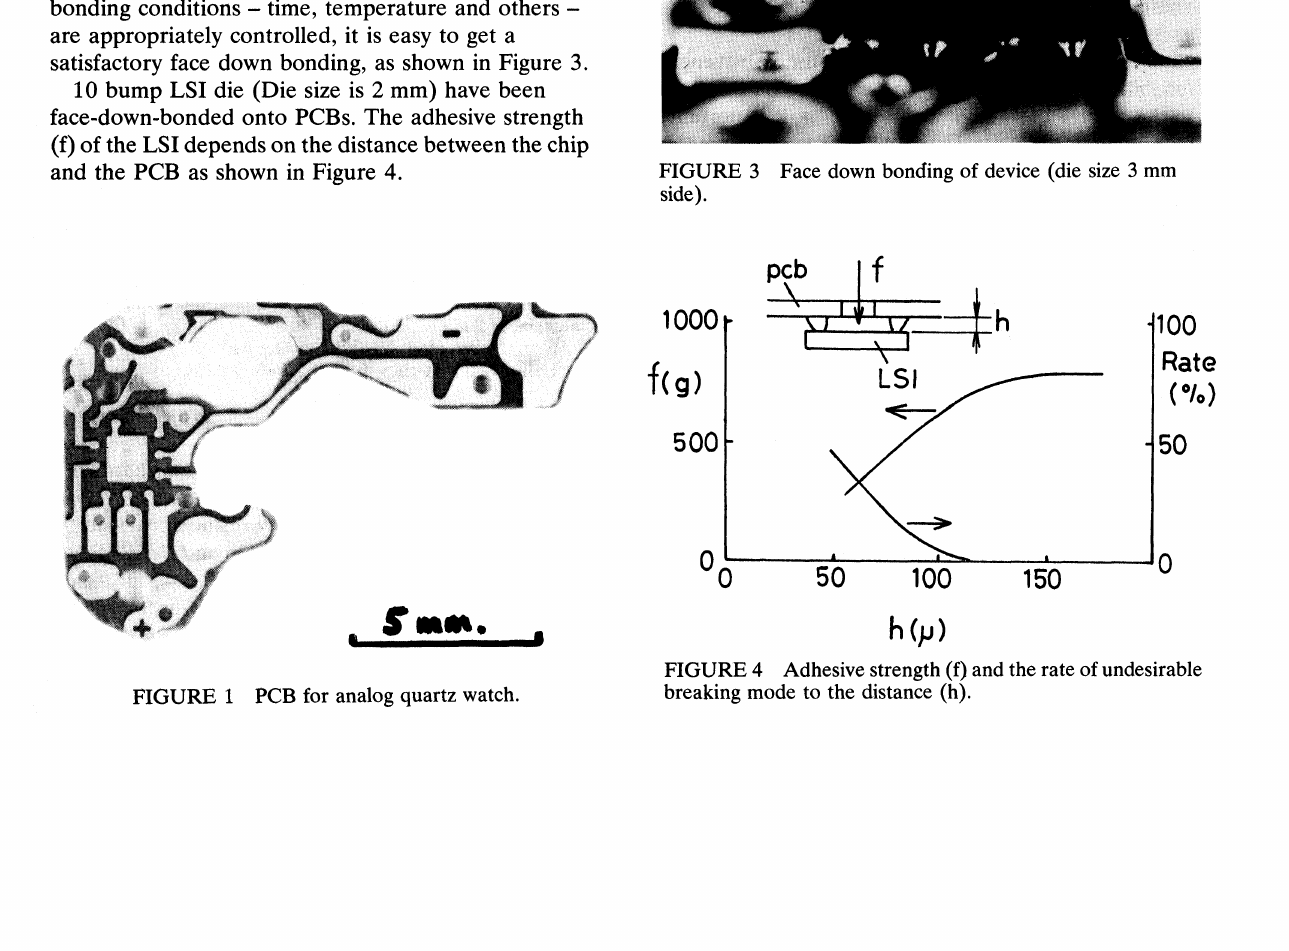
FIGURE 2 Interconnection pattern (minimum time width 80/xm).